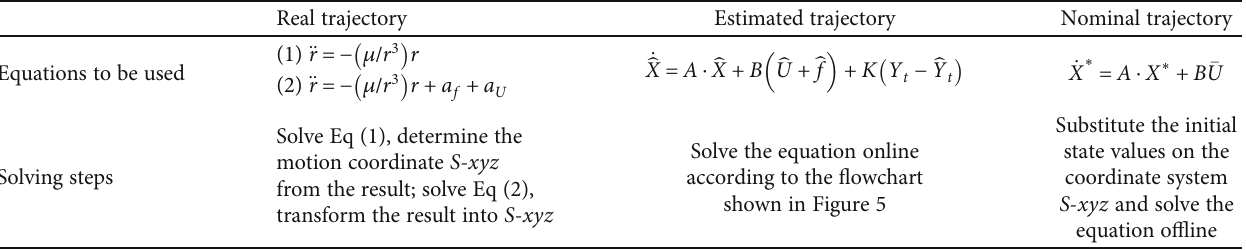
Table 2: Comparison of three di ff erent